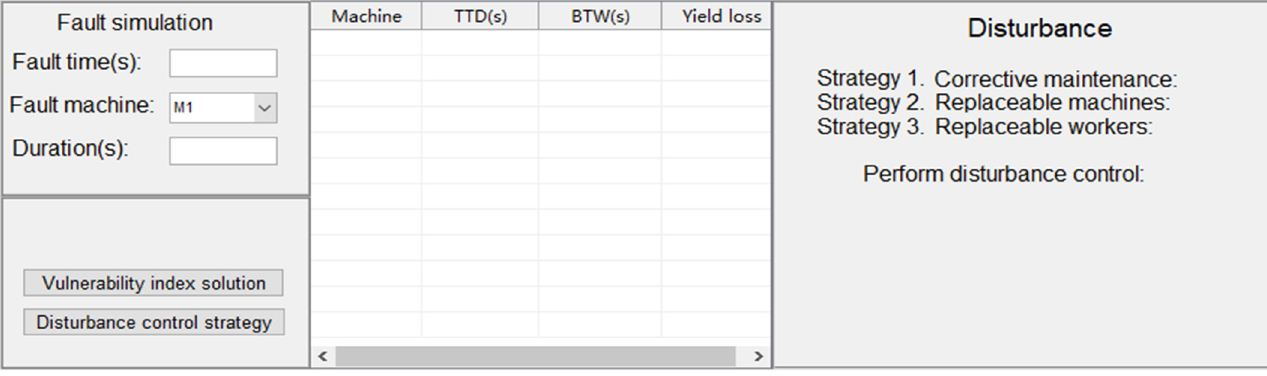
Figure 13. Vulnerability quantitative analysis and disturbance control strategies interface.